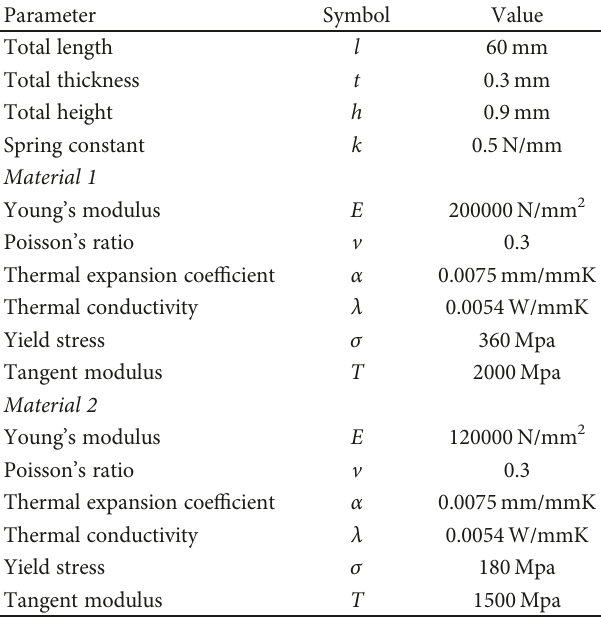
Figure 3: (a) Three-dimensional model simulating the G- fi bers. (b) Detailed view of the two bonded Table 1: List of parameters used to de fi ne the G-cell model.